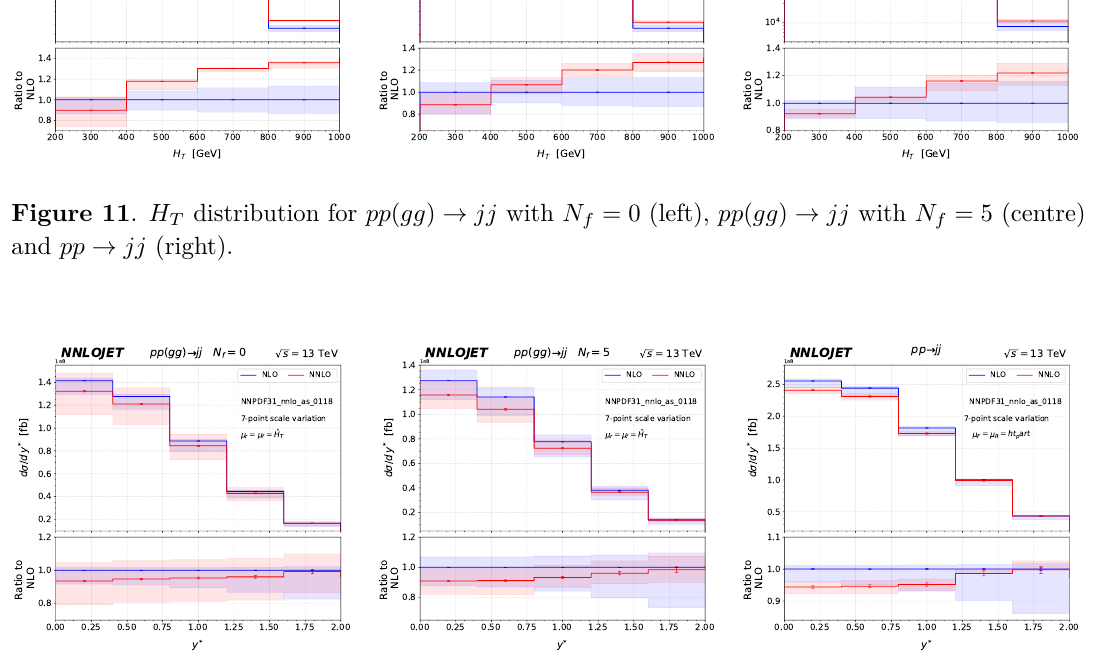
Figure 12 . y ∗ distribution for pp ( gg ) → jj with N f = 0 (left), pp ( gg ) → jj with N f = 5 (centre) and pp → jj